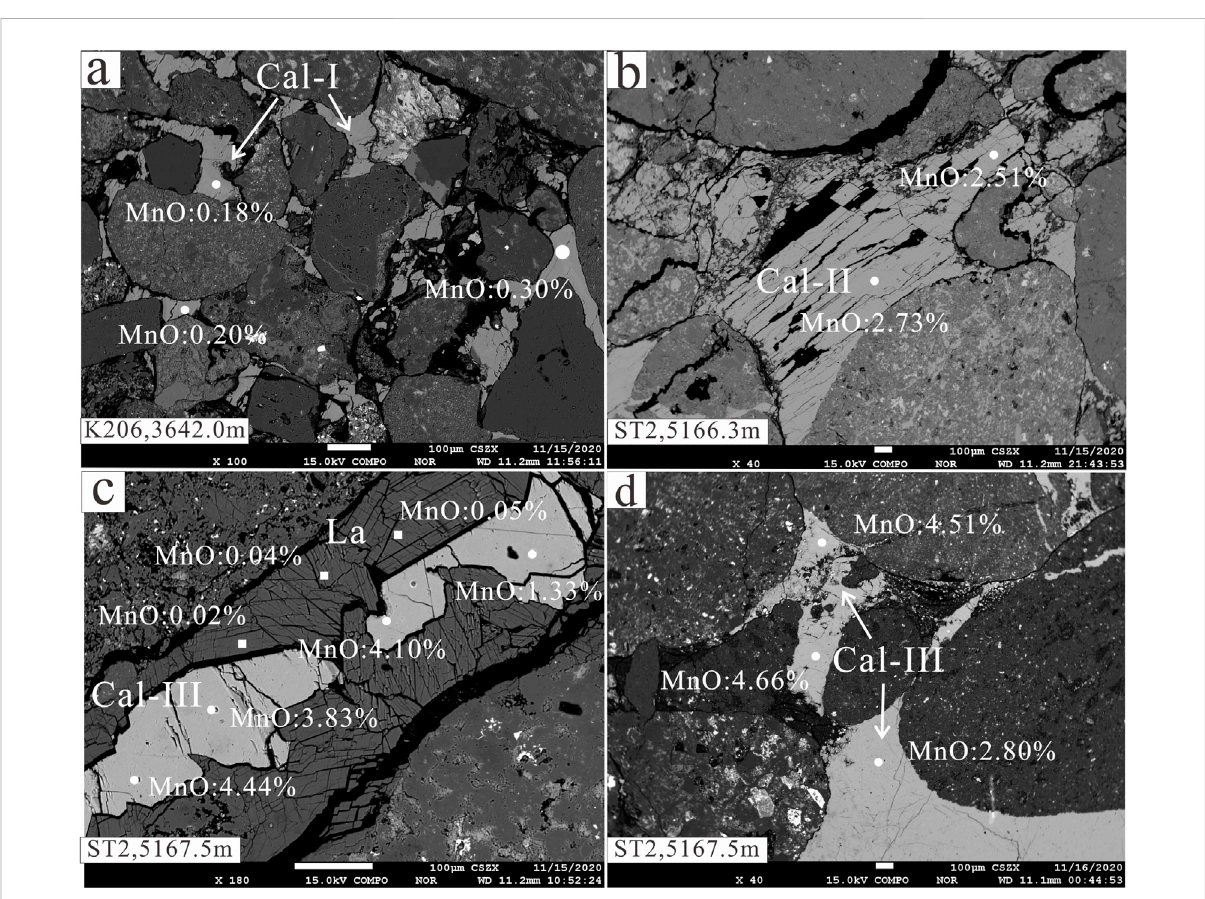
FIGURE 5 Backscattered electron images of laumontite and calcite in the P 3 w Formation. (A) Gray sandstone from a water-bearing layer. (B) Gray sandy conglomerate from an oil-bearing layer. (C) Gray sandy conglomerate from an oil-bearing layer. (D) Gray sandy conglomerate from an oil-bearing layer. Cal-I: early-stage calcite, Cal-II: late-stage calcite I, Cal-III: late-stage calcite II, La: